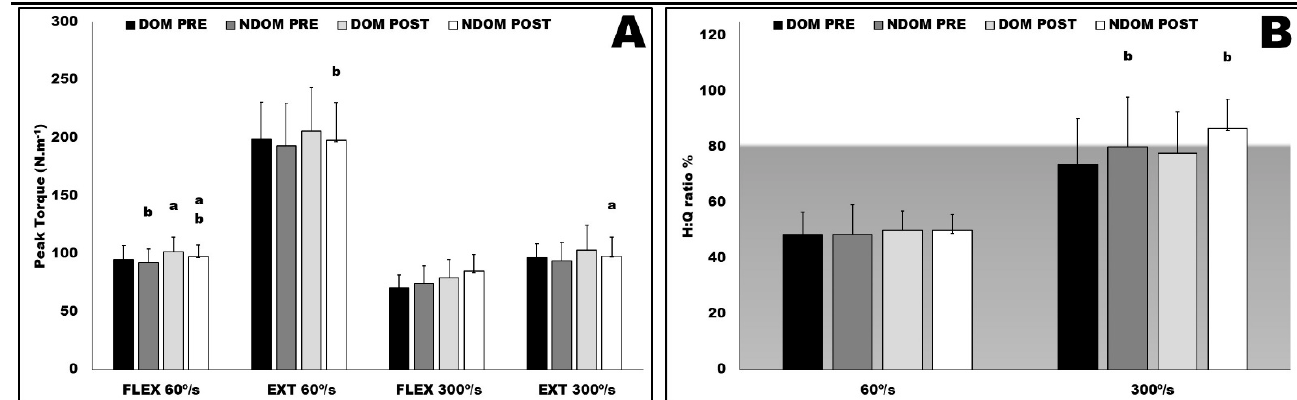
Figure 2. Peak torque ( A ) and H:Q ratio (%) ( B ) at 60°/s and at 300°/s either for DOM and NDOM limbs and both in PRE and POST moments. FLEX = flexors; EXT = extensors; DOM = dominant leg; NDOM = nondominant leg; PRE = prior to the in-season starting; POST = after 15 weeks of a competitive period; a = different than DOM at the same period ( p ≤ 0.05); b = different than PRE for the same leg or muscle group ( p ≤ 0.05). The gray area (<75%) indicates an injury risk zone.